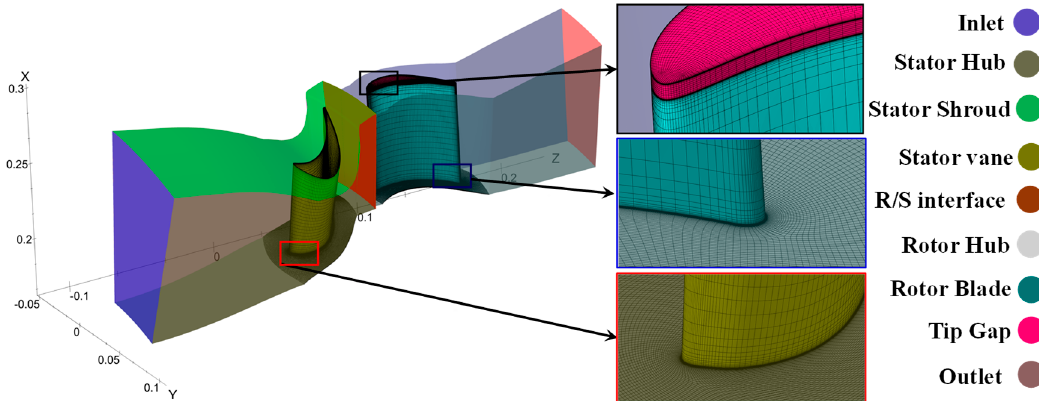
Figure 2. Computational domain.